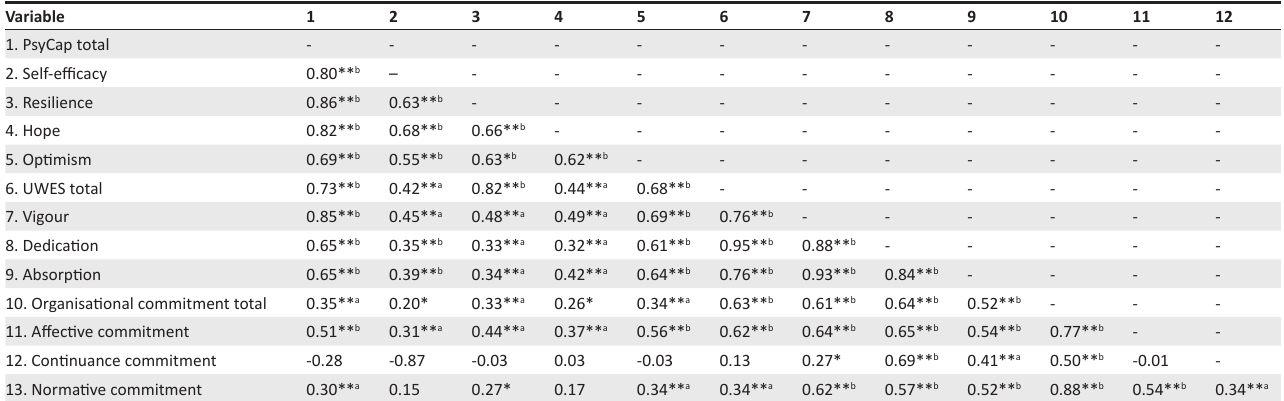
TABLE 3: Pearson product-moment correlation coefficients. Variable